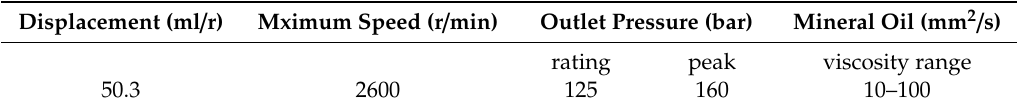
Table 2. Main characteristic parameters.